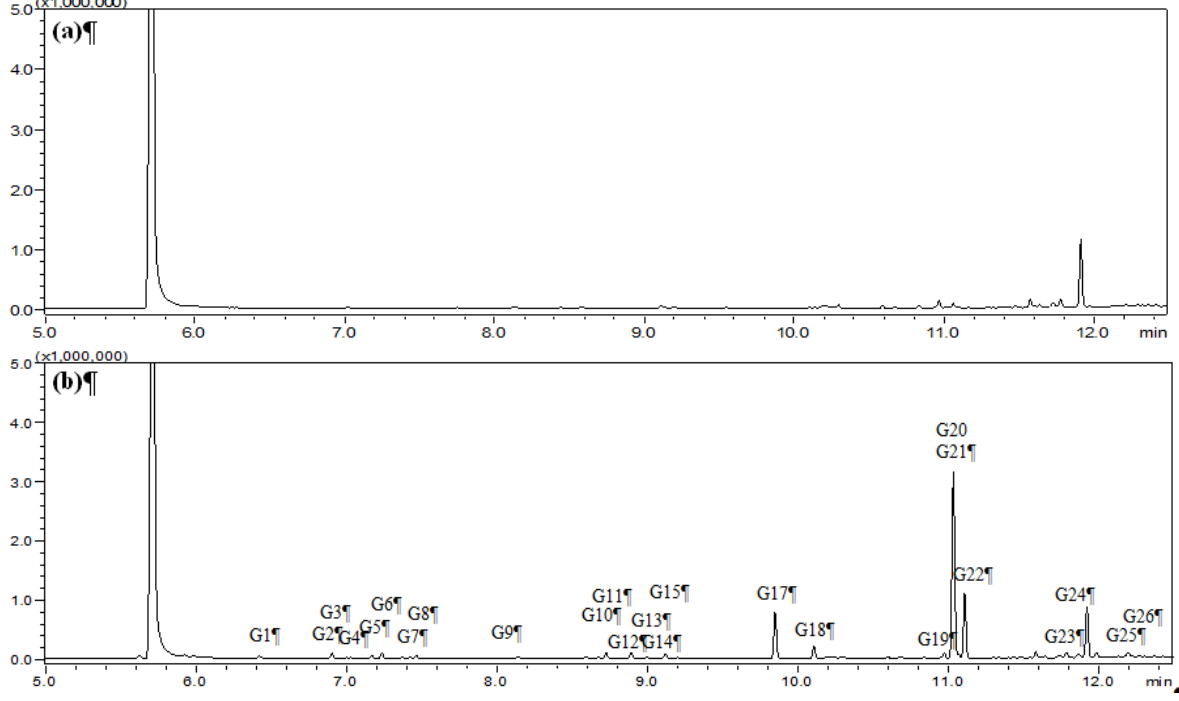
Figure 2. Total ion chromatograms of cerebrospinal fluid (CSF) obtained from ( a ) blank group and ( b ) AR EtOAc extract group using HS-SPME-GC-MS.